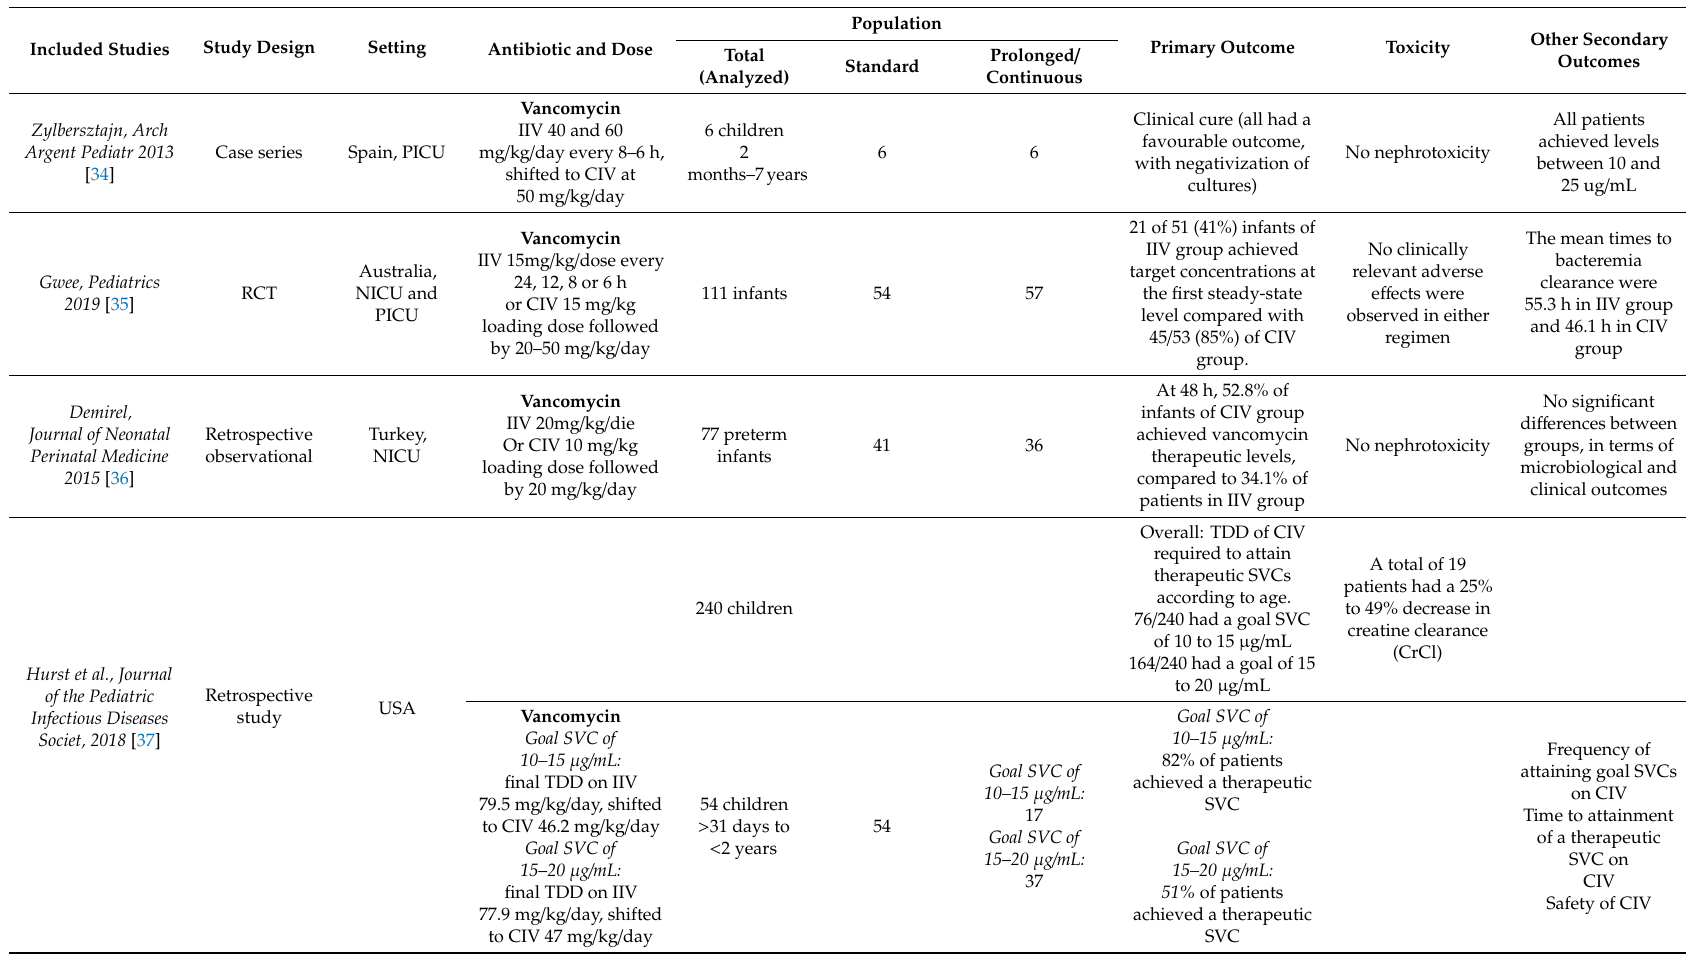
Table 1. Characteristics of included studies, reporting data on pediatric patients on intermittent vs. continuous infusion—study design, setting, population, antibiotic dose, toxicity,